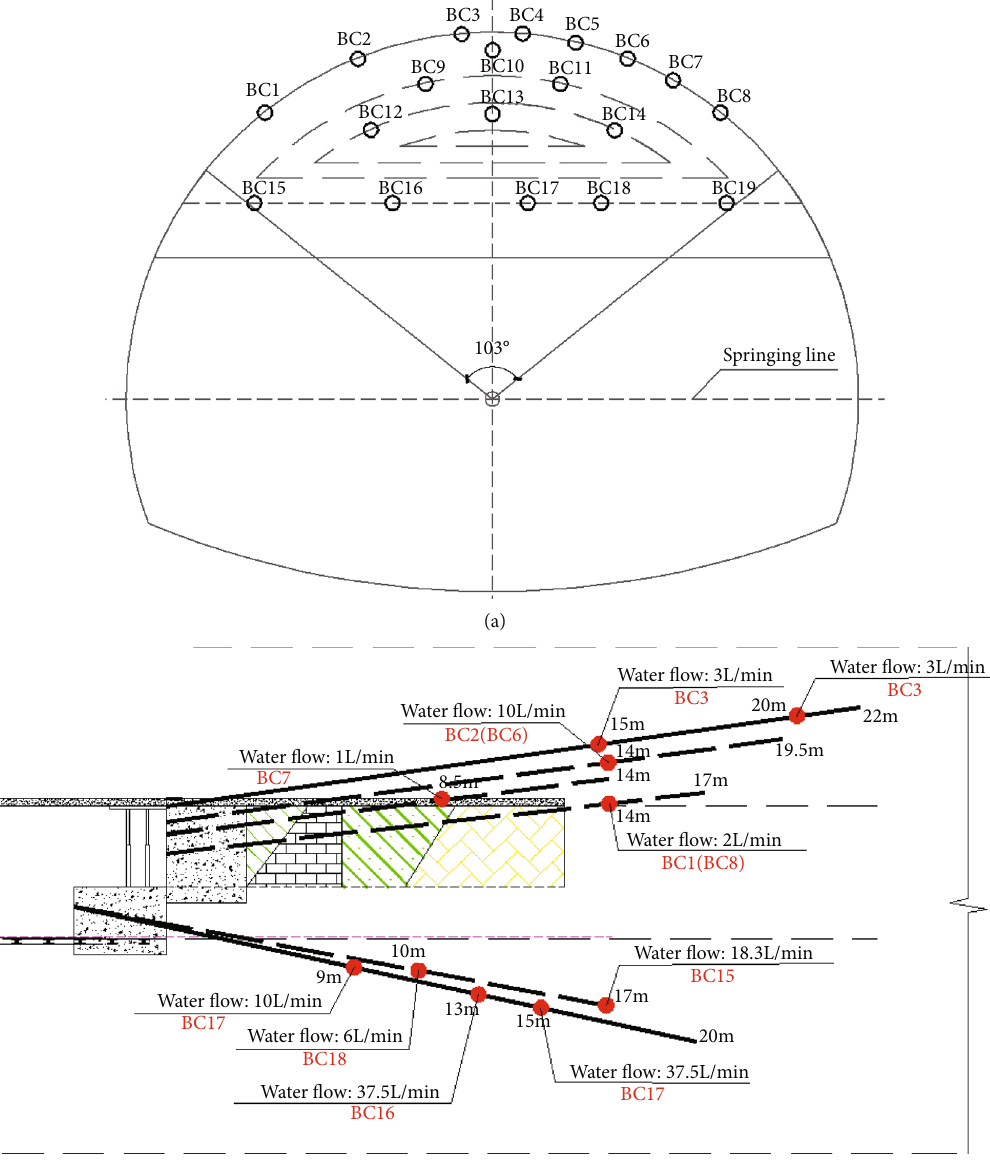
Figure 16: Drilling results of supplementary grouting. (a) Borehole layout in cross section. (b) Borehole layout in longitudinal pro fi le and water gushing condition of some